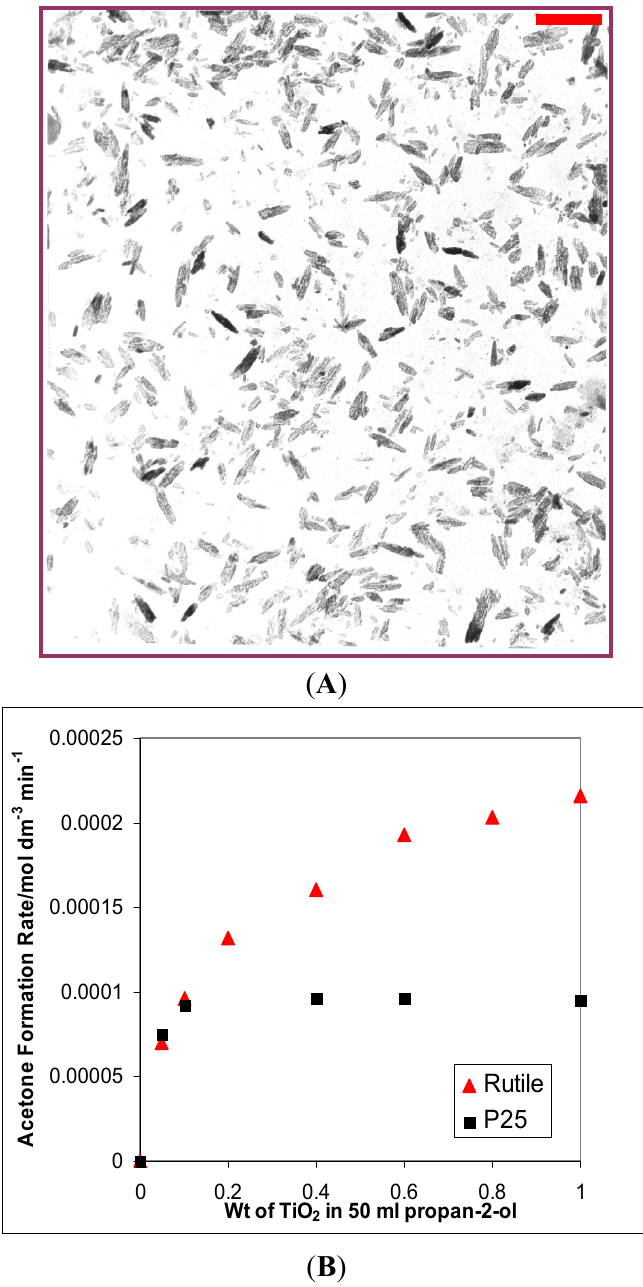
Figure 1. ( A ) Transmission electron micrograph of Rutile #1. The red bar represents 100 nm; ( B ) Comparison of the photocatalytic activity for propan-2-ol oxidation of Rutile (#1) and P25 as a function of catalyst